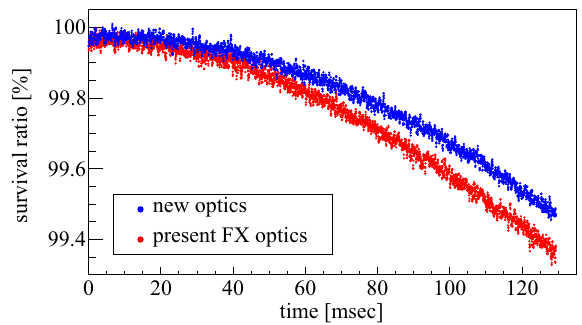
FIG. 12. Beam survival ratios in the MR with the present FX optics (red) and the new optics (blue), measured by the